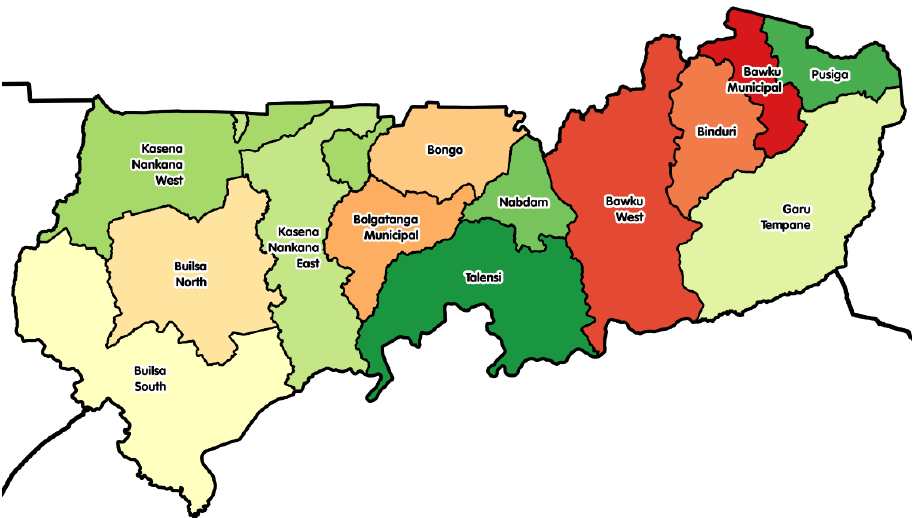
Figure 1. A map of the Upper East region showing its districts.